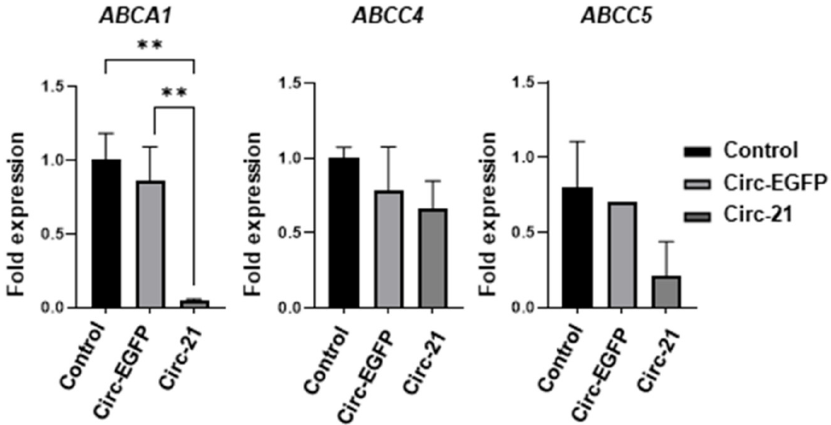
Figure 9. qRT-PCR analysis of drug resistance genes. The Circ-21 decreased the expression of ABCA1 , ABCC4 and ABCC5 resistance gene. Values represent means ± SD ( n = 3). ** p <